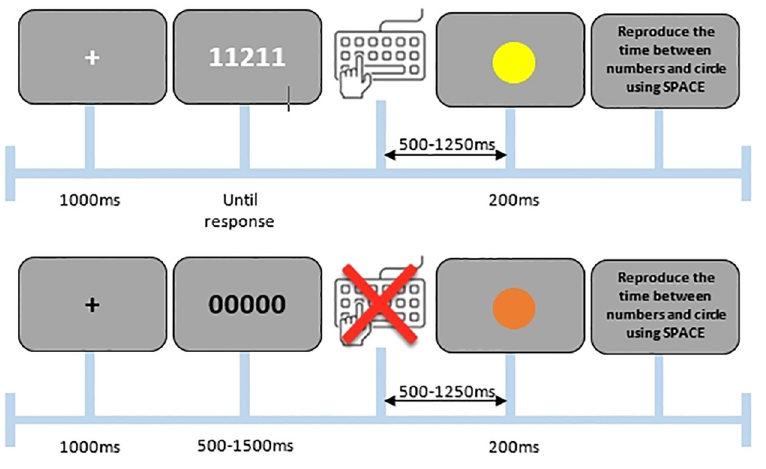
Fig 1. Example of an active (top) and passive (bottom) trial in Experiment